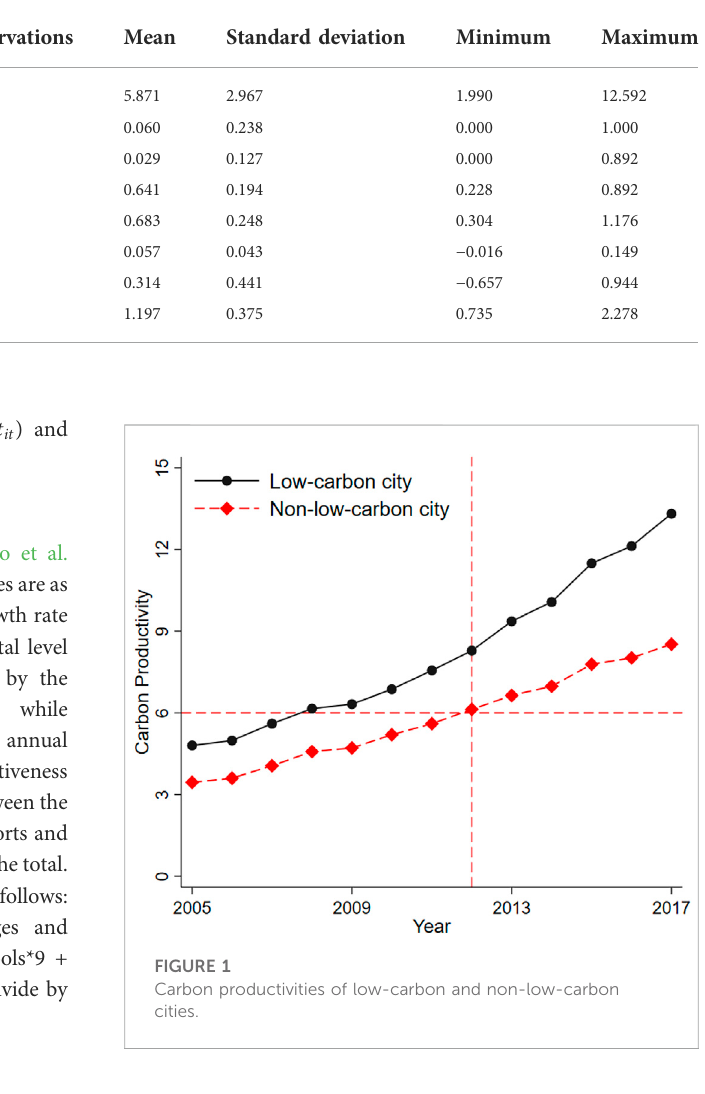
TABLE 1 Variable de fi nitions and descriptive statistics.